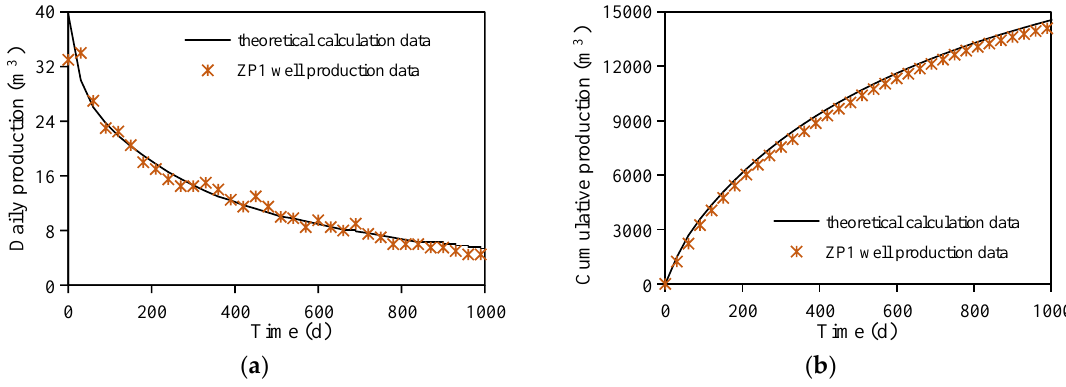
Figure 3. Pressure and pressure derivative behaviors in a multi-stage fractured horizontal well intercepted by the numerical solution and Zerzar [43] analytical solution.